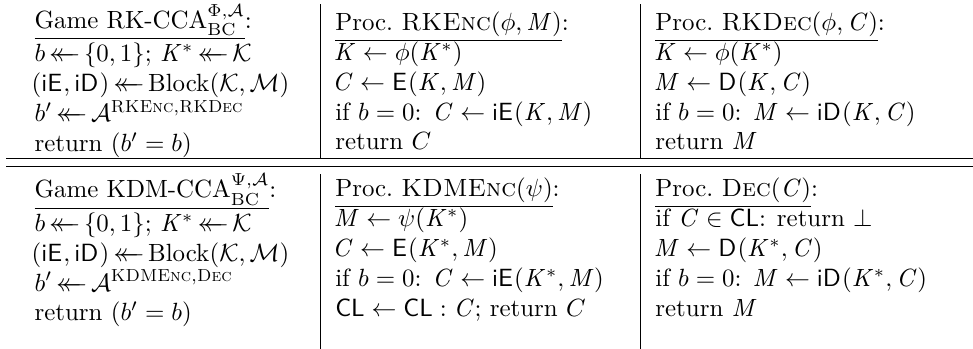
Figure 11: (Top) Game defining the Φ-RK-CCA security of a blockcipher BC = ( E , D ).